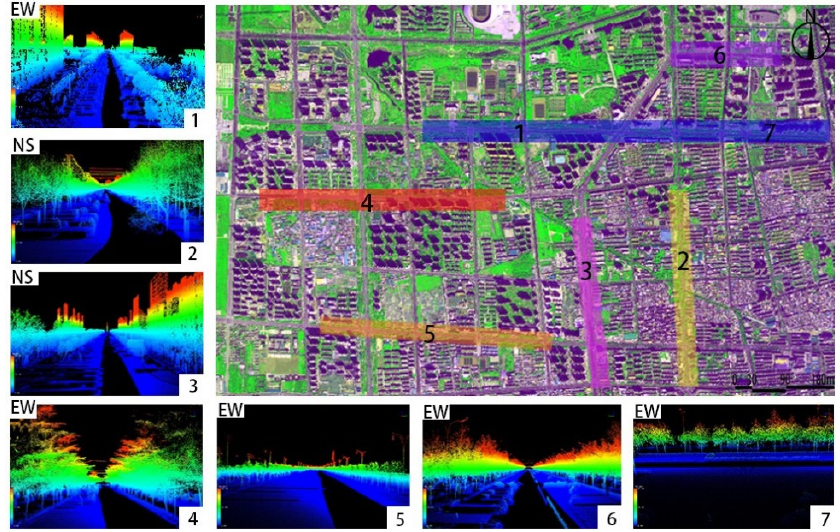
Figure 2. Test road point cloud quadrat.